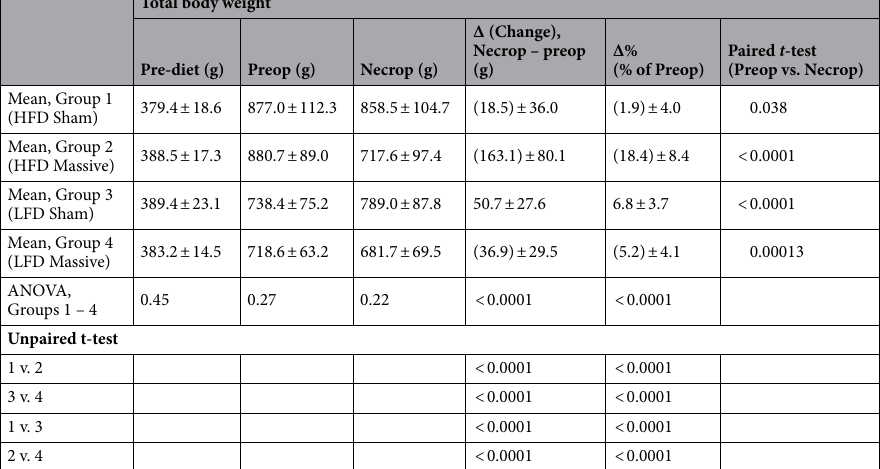
Paired t-test (Preop